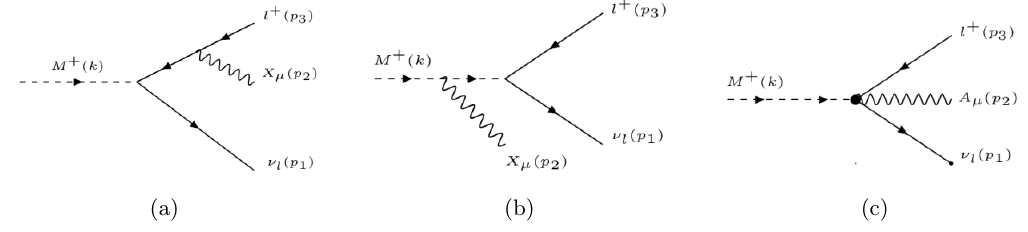
Figure 1 . The Feynman diagrams (a,b) contributing to M lY , Y denoting invisibles, in the U(1) X model and the structure dependent diagram (c) in QED.